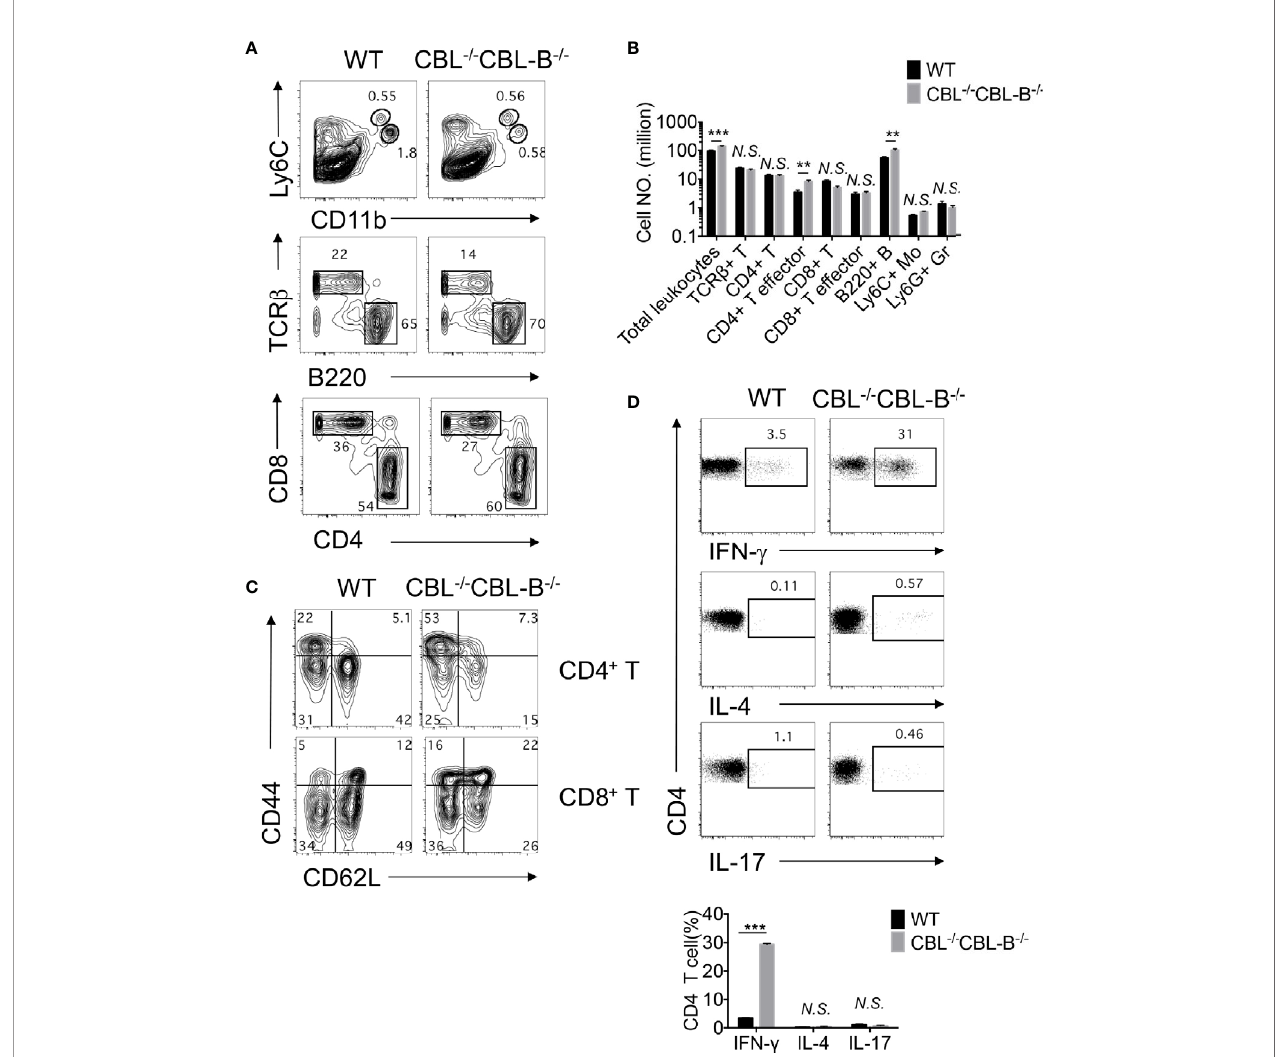
FIGURE 5 | Impaired immune quiescence in CBL -/- CBL-B -/- mice. (A, B) Flow cytometry and statistical analyses of the spleen cellularity (n = 5). (C) Activation status of splenic CD4 + and CD8 + T cells. Shown are contour maps of CD44 vs CD62L staining of naïve (CD44 lo CD62L hi ), memory/effector (CD44 hi CD62L hi ), effector (CD44 hi CD62 lo ) T cells (n = 5). (D) T effector T cell subsets in the spleen. Th1, Th2, and Th17 cell subsets were stained by anti-TCR b , CD4, and intracellular IFN- g , IL-4, and IL-17, respectively (n = 3). Data are mean ± SEM. of at least two independent experiments (A – D) . N.S., not signi fi cant; **p < 0.01; ***p <